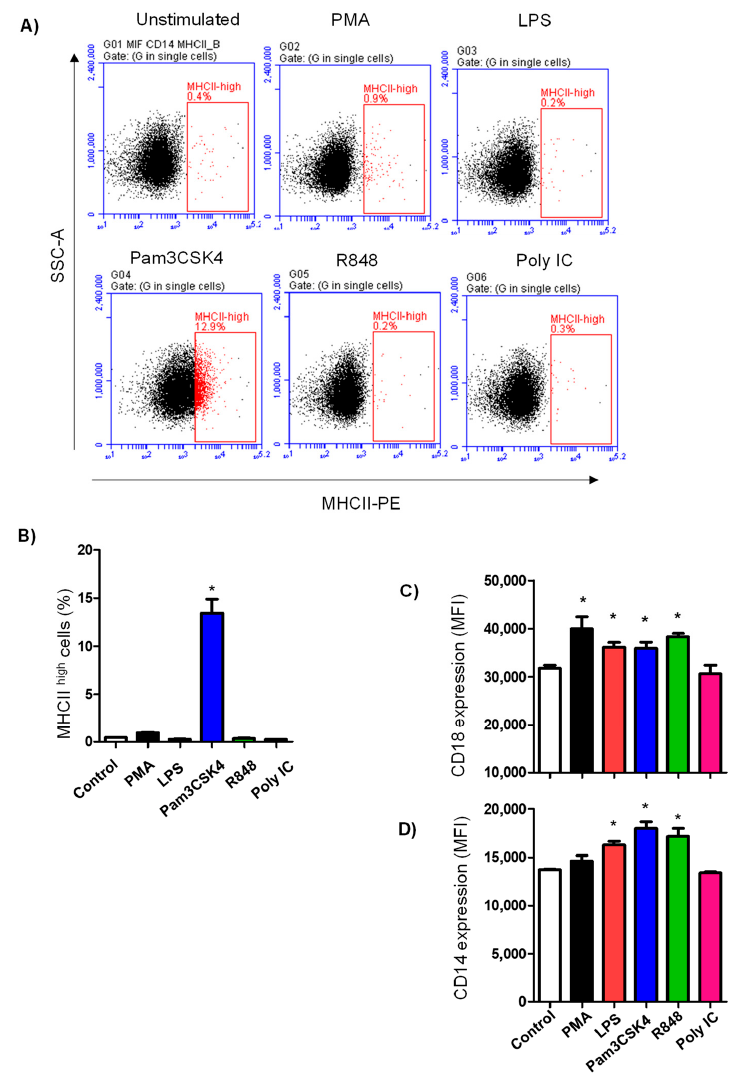
Figure 4. Analysis of the abundance of selected neutrophil cell-surface antigens. Neutrophils (after stimulation) were stained with anti-CD14, anti-MHCII, anti-CD172a, anti-CD44, anti-CD11a, and anti-CD18 antibodies, and the stained cells were analyzed by flow cytometry. ( A ) Representative density plots showing the expression of MHCII molecules on control and stimulated neutrophils. ( B ) The percentage of MHCII high neutrophils within the neutrophil population. Mean fluorescence intensity (MFI) of neutrophils stained with antibodies to CD18 ( C ) and CD14 ( D ) were calculated and presented graphically as mean ± SEM. * indicates significant difference in the FSC-A means between stimulated and non-stimulated cells with p values less than 0.05. 3.5. Stimulation with TLR Ligands Does Not Affect Cell Vitality of Camel neutrophils Neutrophil cell vitality was evaluated by the analysis of cell necrosis and apoptosis using flow cytometry and combined staining with annexin V and propidium iodide (PI). Cell necrosis was detected based on positive staining with the DNA-binding dye PI and the phosphatidylserine-binding protein annexin V, while single staining with annexin V